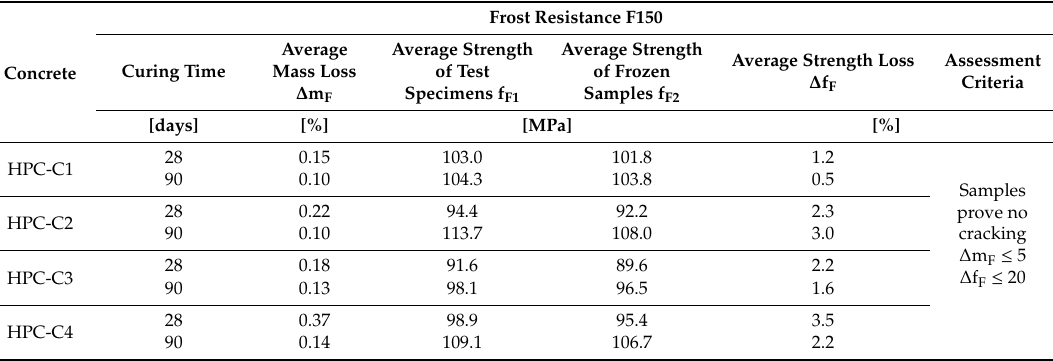
Table 14. Frost resistance F150 test results of HPC